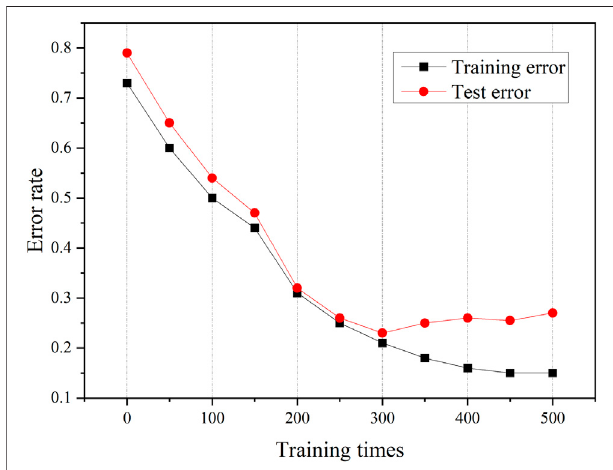
FIGURE 8 | Variation curves of training error and test error over time.